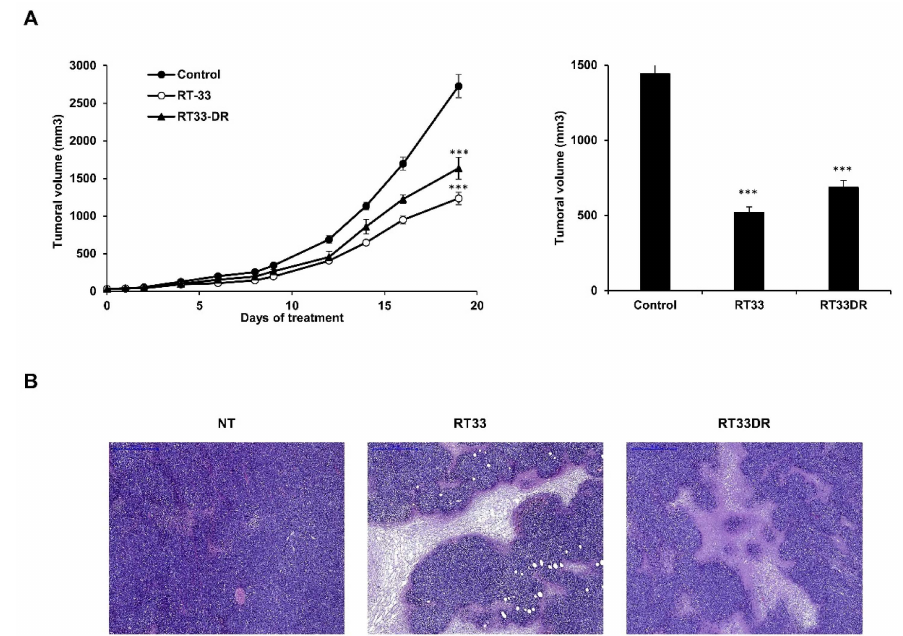
Figure 8. RT33 and RT33DR inhibit tumor growth in vivo in a mouse model for the S é zary syndrome. ( A ) Mice were engrafted subcutaneously with HUT78 S é zary cell line. Animals with preexisting tumors were treated daily with i.p. injections of RT33 or RT33DRM in normal saline (5 mg / kg) or normal saline as control. Tumors were calipered throughout the study and data were plotted as means ± s.e.m. ( n = 7 mice per group). *** p < 0.005 relative to control. Subsequently, tumors were excised, stripped of non-tumor tissue and tumors volumes were calculated. ( B ) Representative pictures of H&E staining of tumors treated with RT33, RT33DRM, or normal saline. The scale bar represents 500 µ